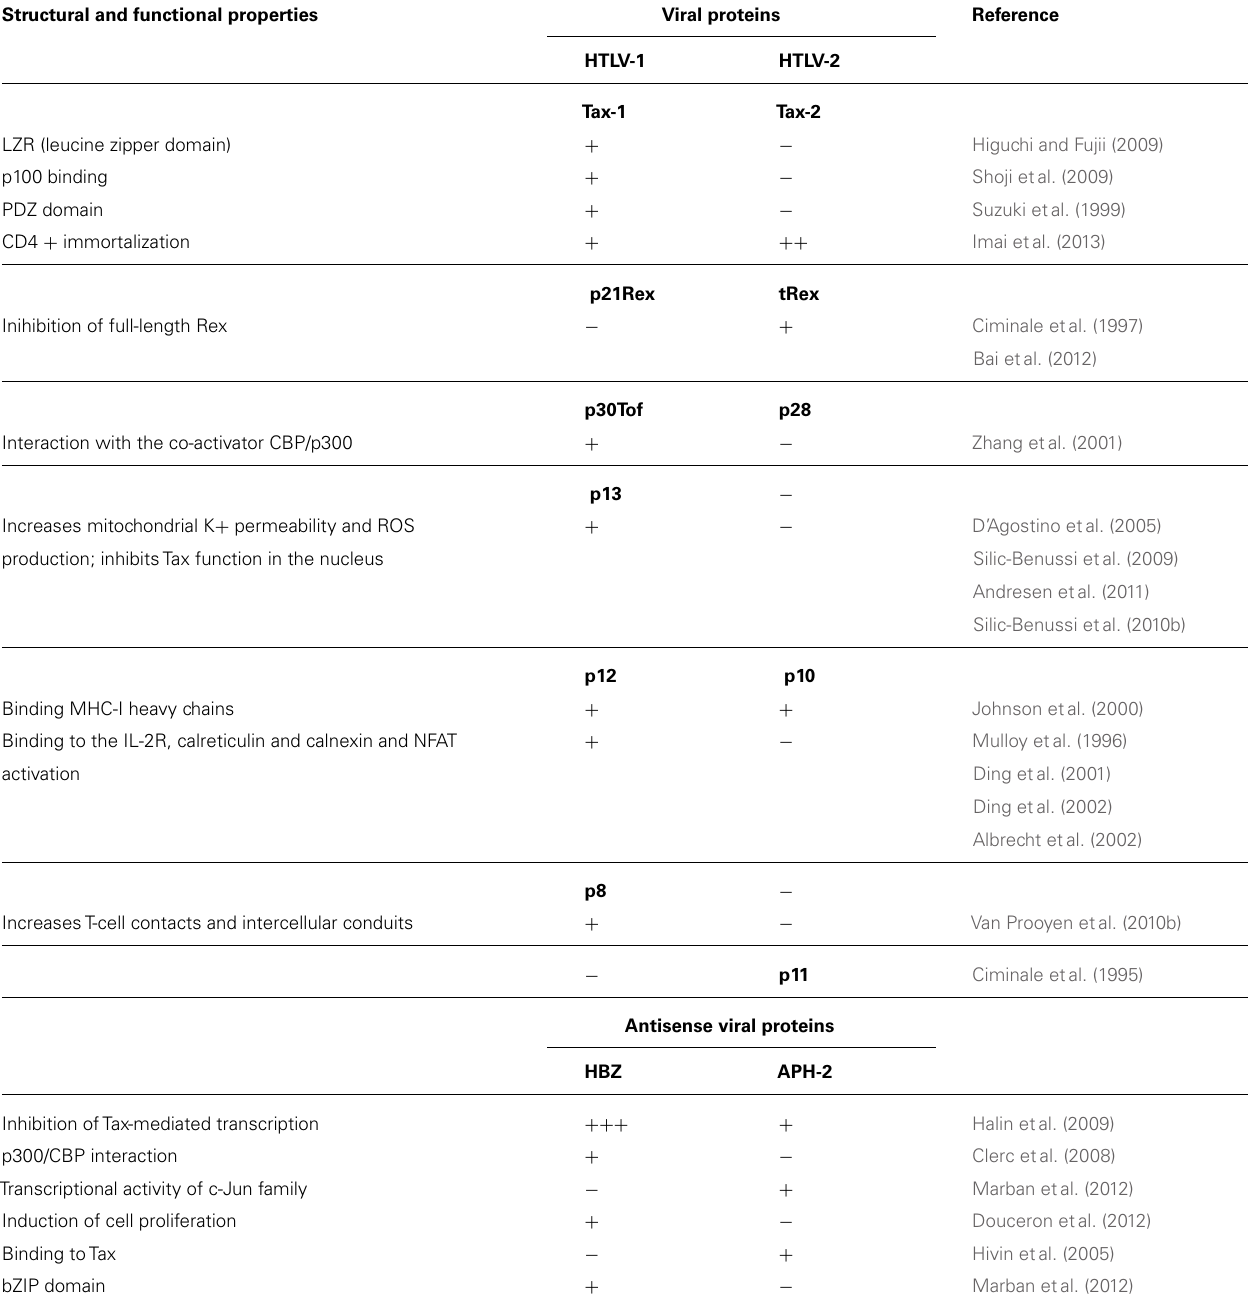
Table 1 | Structural and functional differences between HTLV-1 and HTLV-2 gene products. Structural and functional